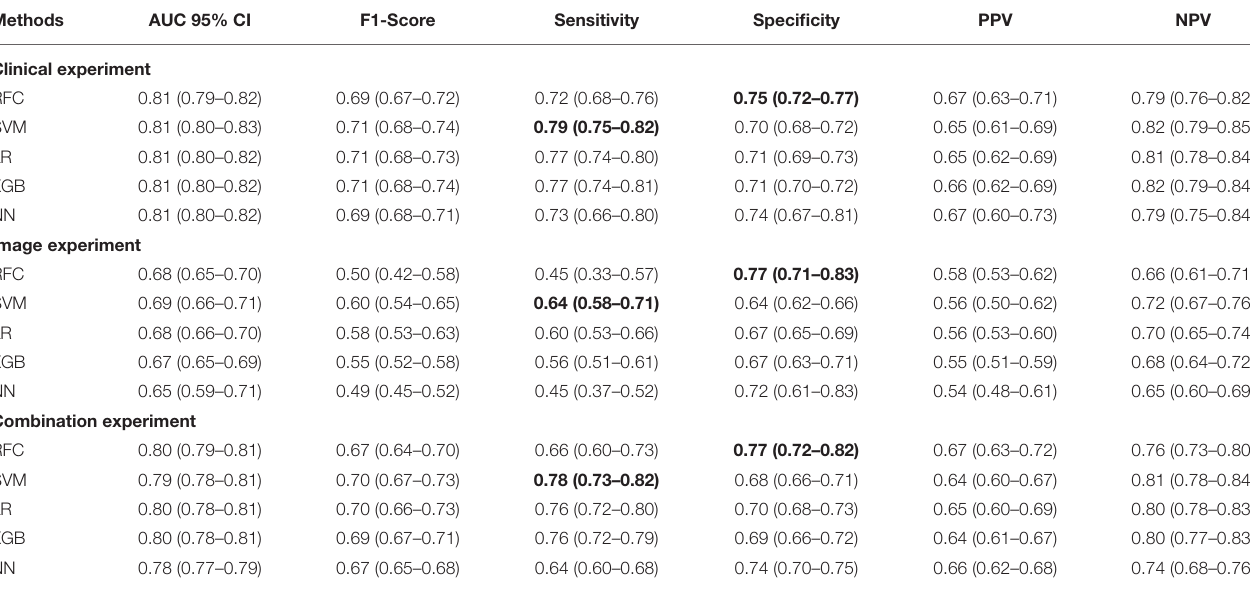
TABLE 2 | Results of the clinical, image, and combination for the radiomics approach for predicting the good functional outcome (mRS ≤ 2). Methods